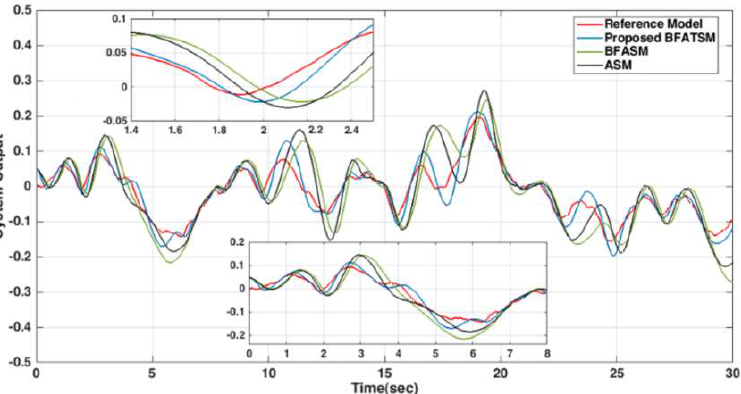
Figure 4. The system output with ASM [1] and BFATSM [2] controller compared to reference model.